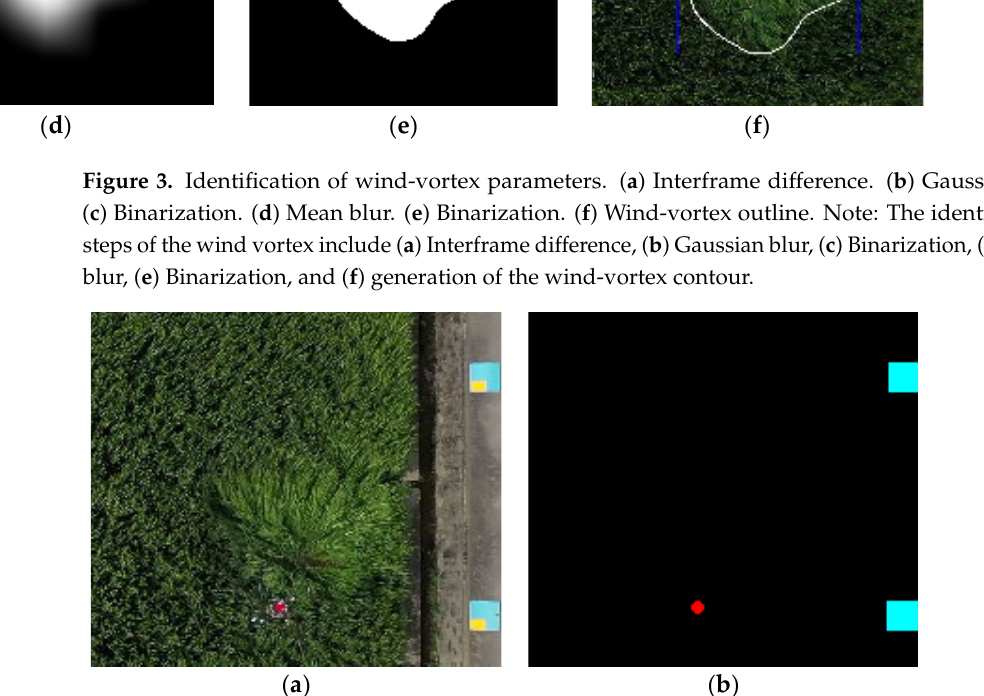
Table 2. Flight parameters of the UAV used for plant protection.